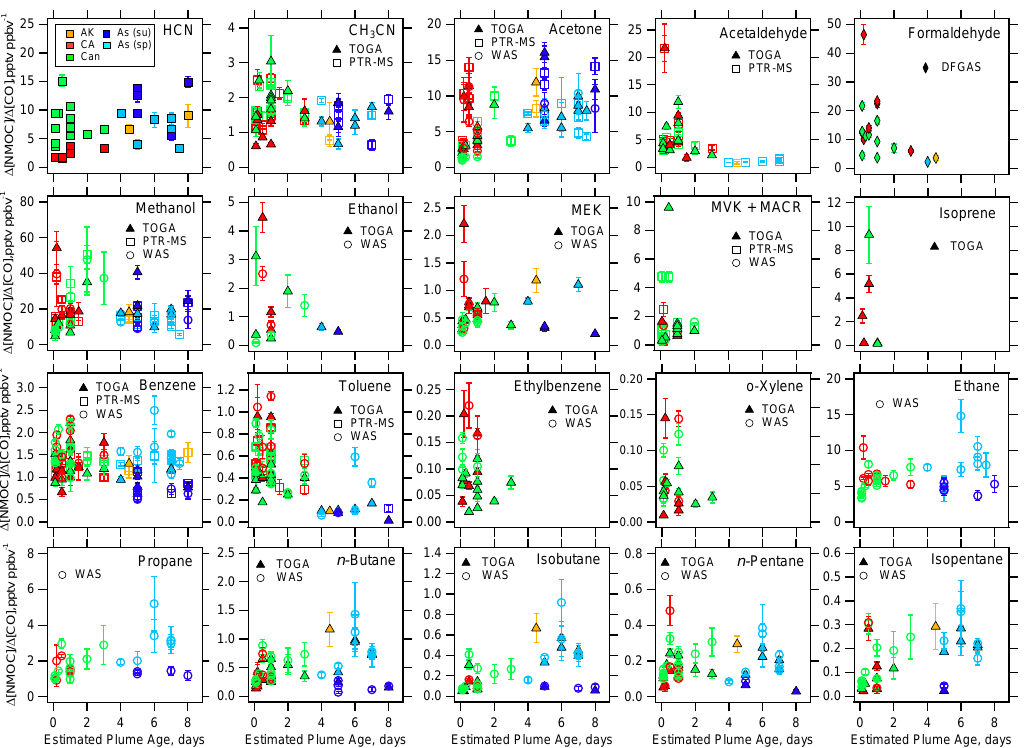
Fig. 7. Plots of observed NEMRs for several NMOCs to CO from individual BB plumes observed during ARCTAS against estimated plume age. Error bars show the standard error in the slope of a linear fit to [NMOC] vs. [CO] for each BB plume. Points are colored by the BB source region and, for Asian BB, time of year (spring or summer), as shown in the legend on the HCN